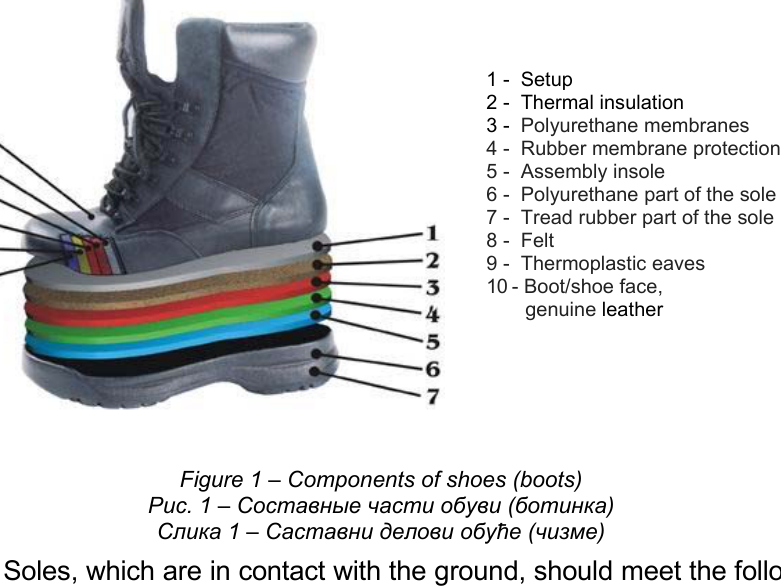
Figure 1 – Components of shoes (boots) Рис . 1 – Составные части обуви ( ботинка ) Слика 1 – Саставни делови обуће ( чизме